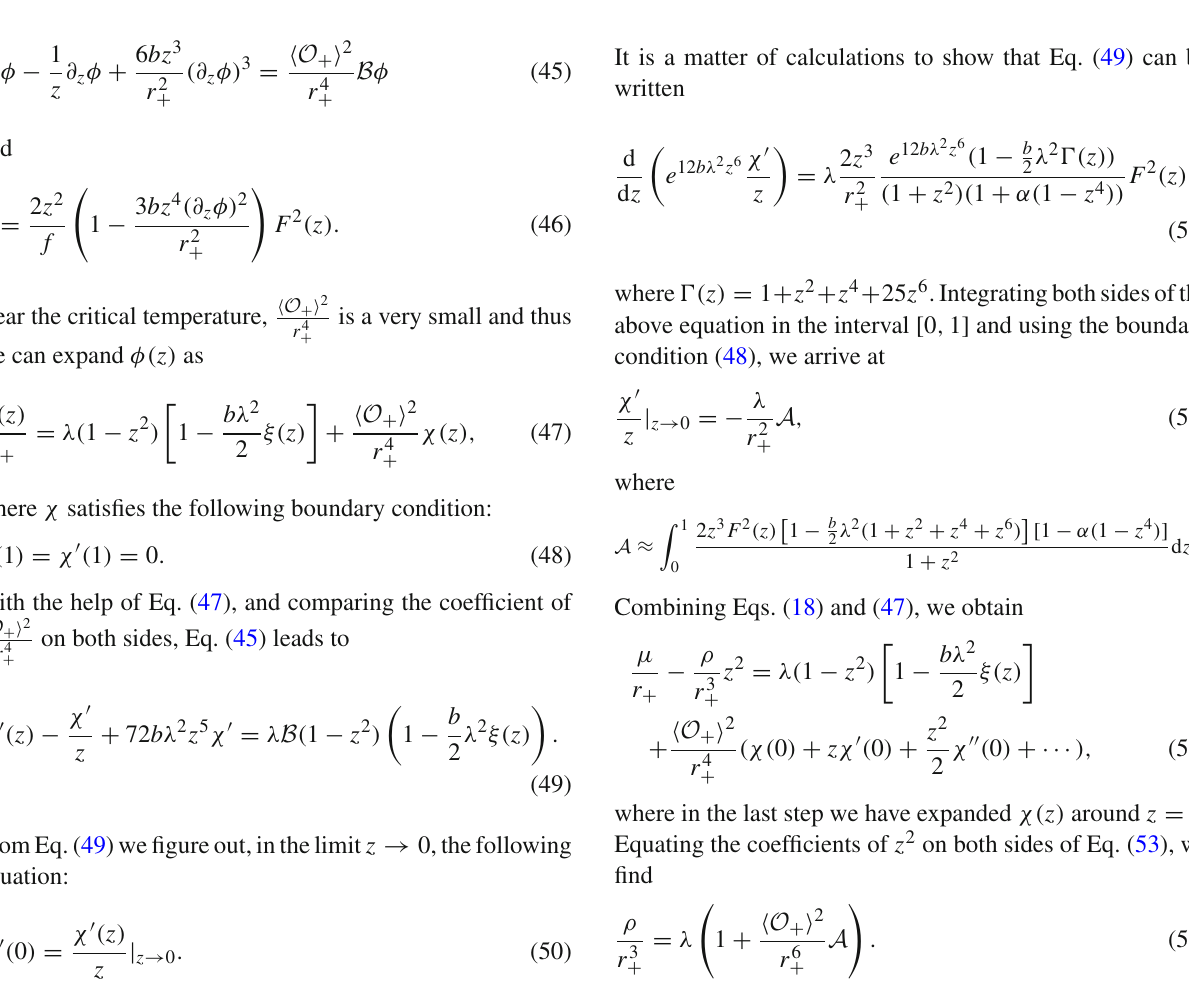
Fig. 1 The behavior of ψ( z ) versus z for Gauss–Bonnet HSC and for ˜ m 2 = − 3 and different α and